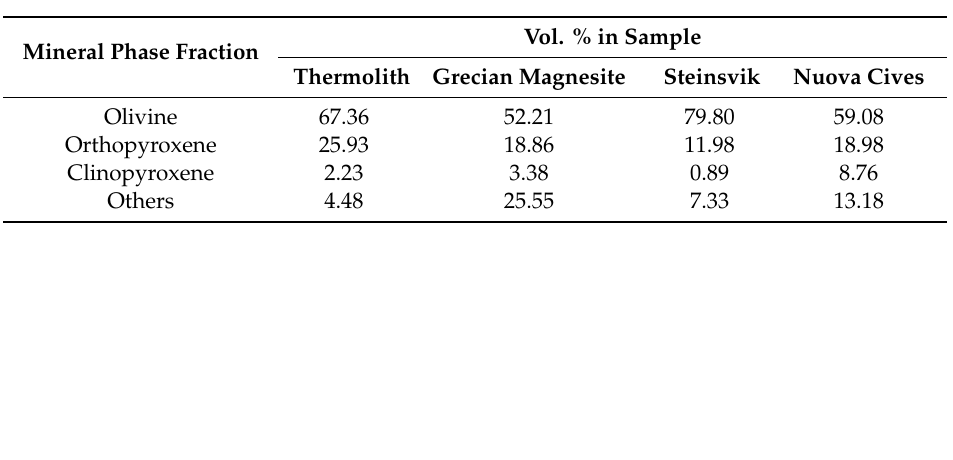
Table 4. Quantitative analysis by QEMSCAN ® of four di ff erent samples of olivine bearing rocks from